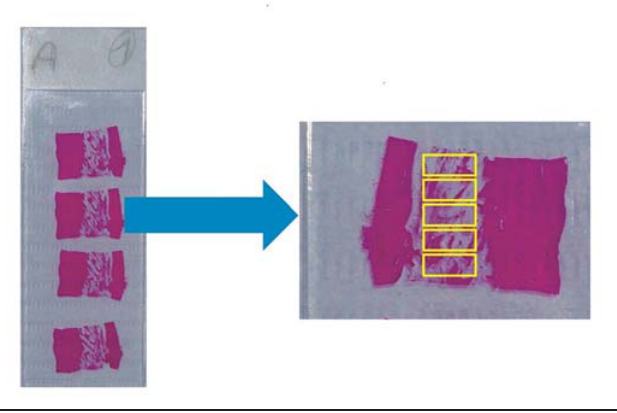
Fig. 2. Images of center of each alveolus following long axis with adjacent alveolar bone as reference.